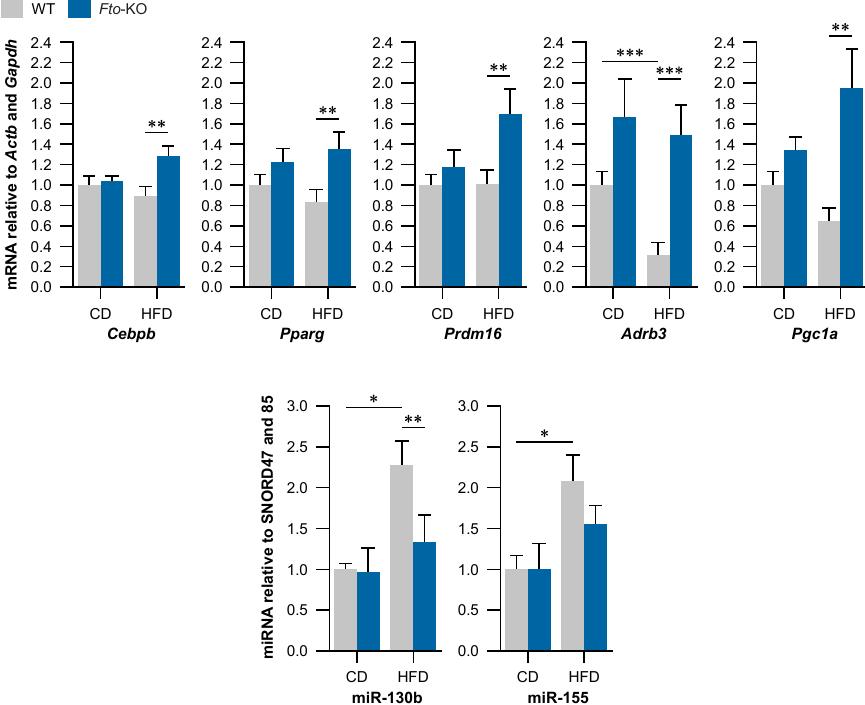
Figure 3. Relative expression of mRNAs and miRNAs related to WAT browning in subcutaneous WAT. The amount of mRNA was normalized using Actb and Gapdh as reference genes and the amount of miRNA was normalized using SNORD47 and SNORD85 as internal controls. WT, wild-type mice; Fto -KO, Fto -knockout mice; CD, control diet; HFD, high-fat diet. Results are shown as mean ± SEM ( n = 5–9 per group in mRNA, n = 4 per group in miRNA). Two-way ANOVA followed by simple main effects analysis with Bonferroni correction if there was significant interaction effect or moderation effect, * p < 0.05, ** p < 0.01, *** p < 0.001.